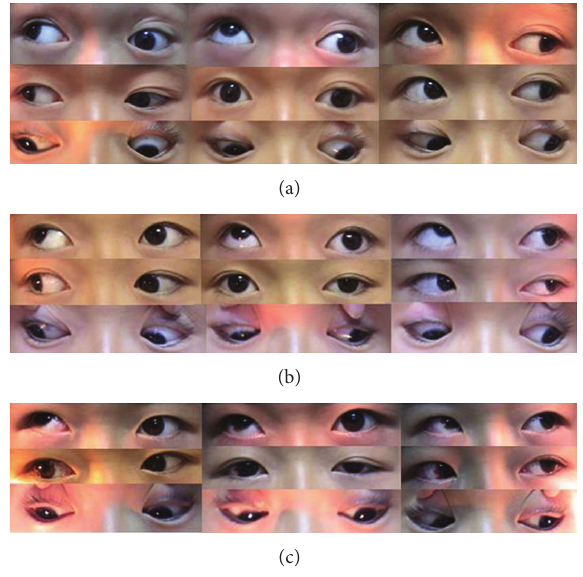
Figure 5: (a) Preoperative images for patient 10. Before surgery insufficient supraduction of the left eye complicated by exotropia was noted. The supraduction of the left eye could not pass the midline. (b) After APRMT combined with partial horizontal rec- tus recession-resection on the paralytic eye (left eye), insufficient supraduction of the left eye was still present, but the vertical strabismus was corrected at the primary position. The movement of the paralytic eye was improved and exotropia was still present. (c) After horizontal rectus recession-resection on the contralateral (right) eye 2 months later, both horizontal and vertical strabismuses were corrected at the primary position. The movement of the paralytic eye was improved, although the supraduction was still